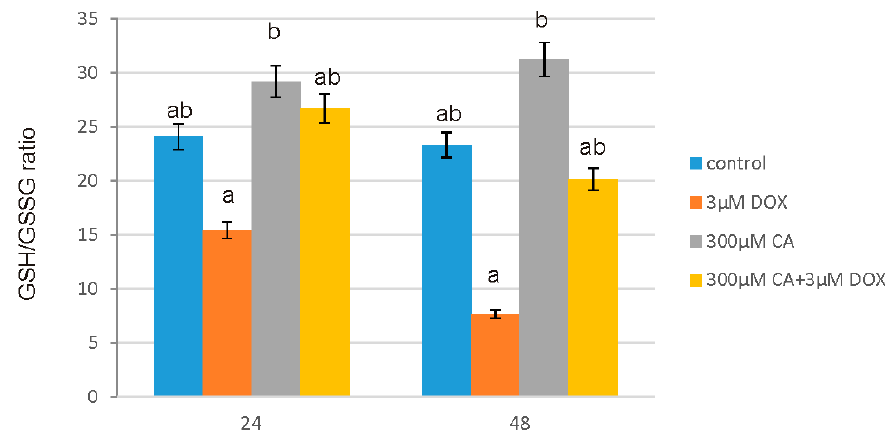
Figure 8. The effect of DOX, CA and CA + DOX on GSH/GSSG ratio in fibroblasts. The cells were incubated with 3 μ M DOX, 300 μ M CA and DOX (3 μ M) combined with CA (300 μ M) for 24 h and 48 h Mean values from three independent experiments ± SD are shown. Different letters (a, b) indicate statistical differences ( p ≤ 0.05) between control, 3 μ M DOX, 300 μ M CA and DOX combined with CA estimated by Tukey’s test.